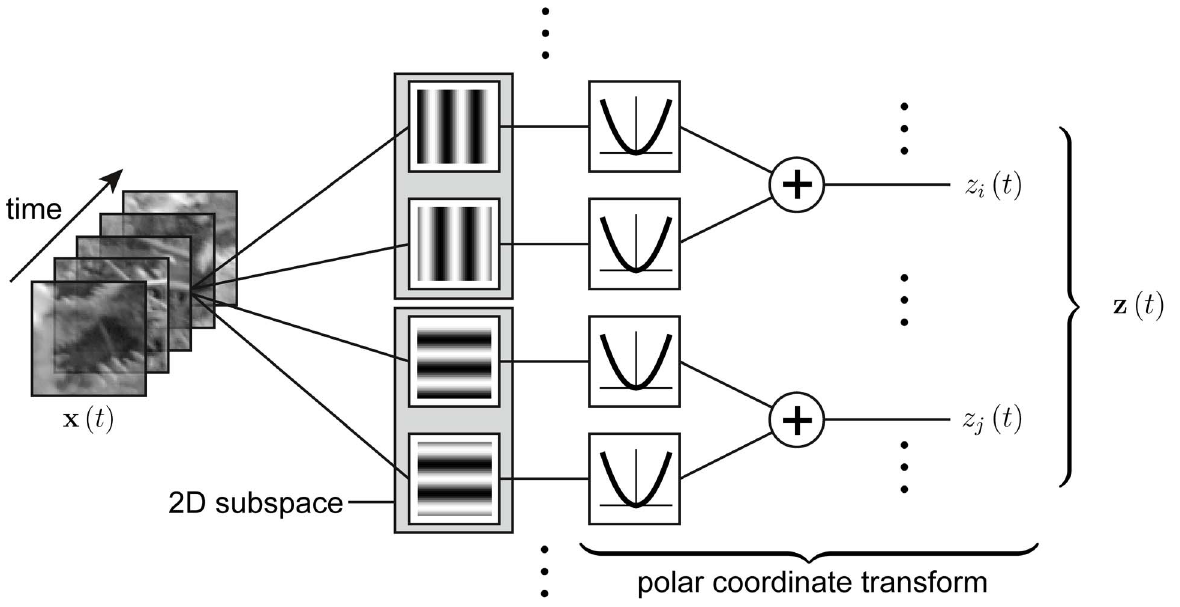
Figure 1. Model structure for both independent subspace analysis (ISA) and slow subspace analysis (SSA). The input signal, e.g. a movie sequence, is applied to several filters. Two filters form a subspace. The output of each filter is passed through a quadratic nonlinearity and summed within each subspace. The output corresponds to the radial component of the 2D subspace. The n = 2 responses z i ( t ) then form the multidimensional output signal z ( t ) . If the filters are the discrete Fourier transform basis where each subspace consists of the two filters which only differ in phase, then the output z ( t ) is the power spectrum of the input signal x ( t ) .